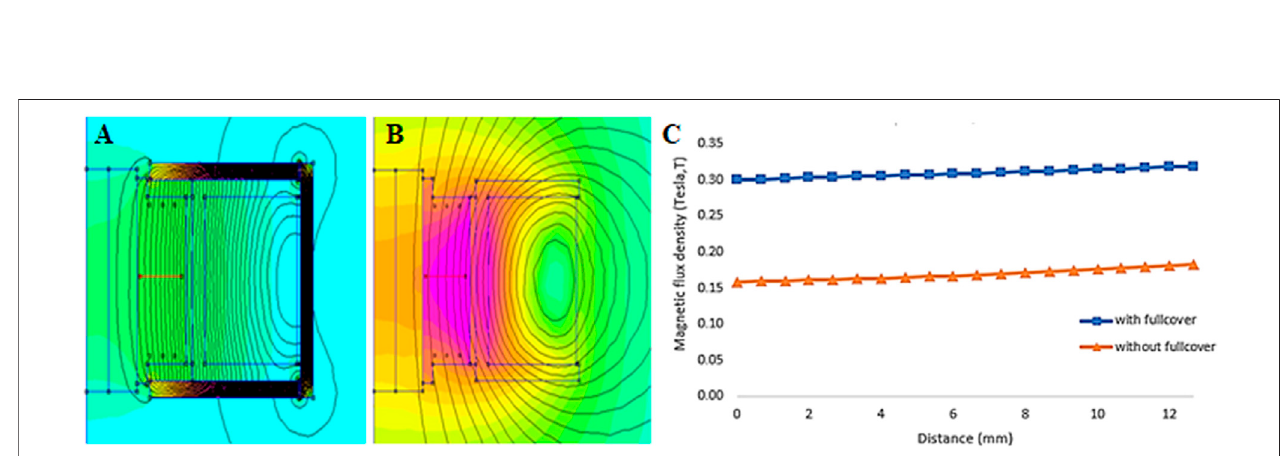
FIGURE 8 | Magnetic fl ux distribution on device structure, (A) with full cover, (B) without full cover, and (C) Magnetic density analysis on the device structure, with and without the application of the full cover.